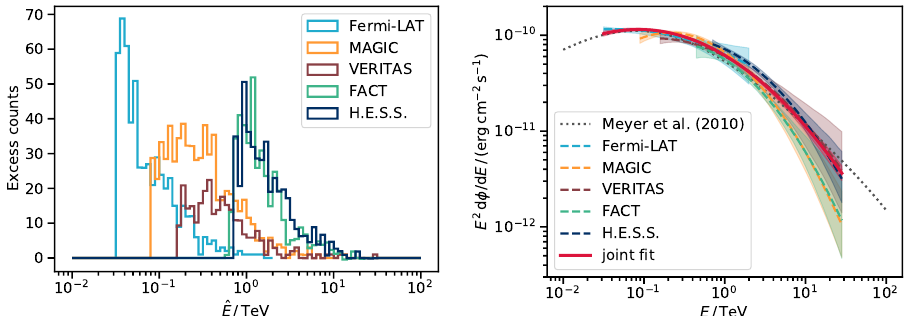
Figure 5. ( Left ): Source counts vs estimated energy extracted via aperture photometry, per each of the instrument datasets in [40]. ( Right ): Estimated flux spectrum of the Crab Nebula obtained from the individual instrument datasets (same colour code as in the figure on the left) and considering all the datasets in the same joint likelihood (red). The grey dashed line represents a bibliographic reference. In all cases the analytical flux model considered in the likelihood is a curved power-law. Figures from